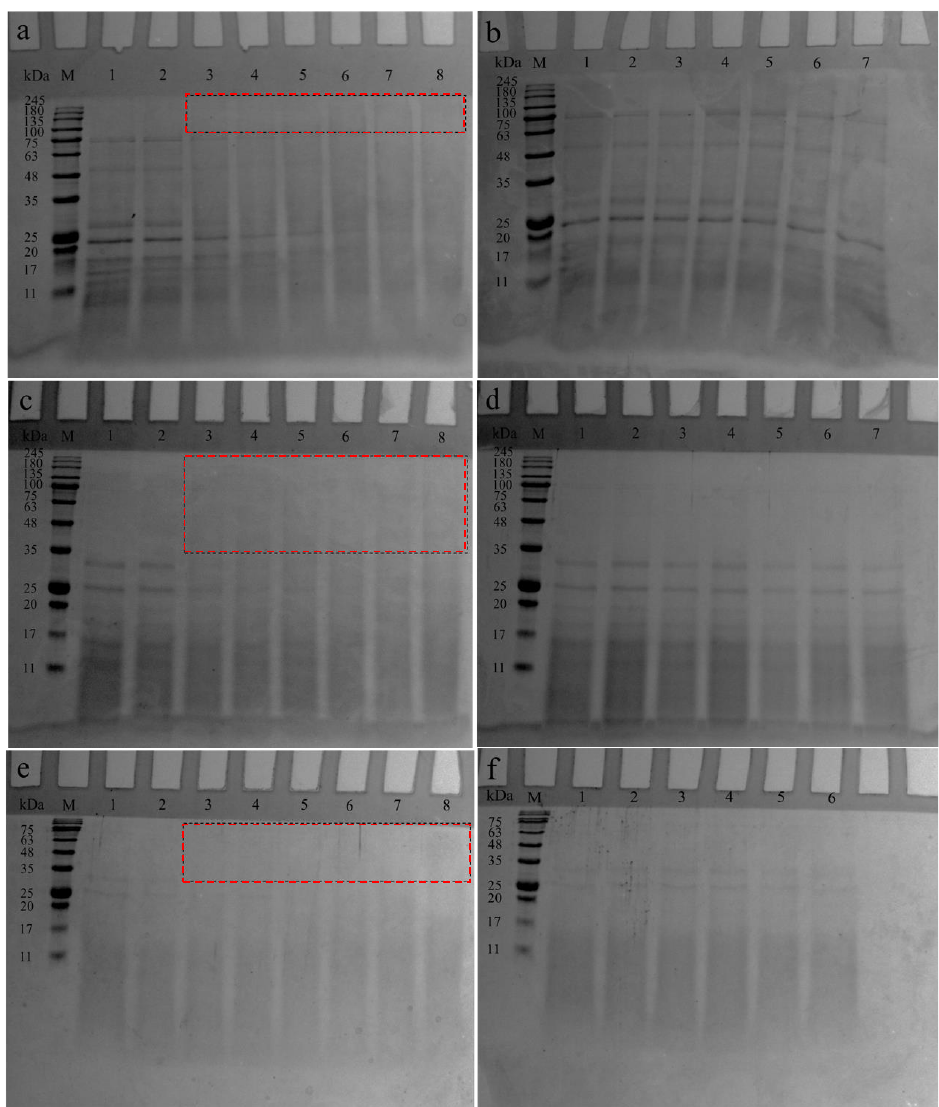
Figure 2. SDS-PAGE patterns of F30-dextran conjugate ( a ), F30 ( b ), F30-10-dextran conjugate ( c ), F30-10 ( d ), F10-dextran conjugate ( e ), and F10 ( f ) incubated at 60 °C for 0 – 24 h (M, Marker; for graph a, c, and e, lane 1 represents the F30, F30-10, or F10; lanes 2 – 8 represent the conjugates incubated for 0, 2, 4, 6, 12, 18, and 24 h; for graph ( b ) and ( d ), lanes 1 – 7 represent the F30 or F30-10 incubated for 0, 2, 4, 6, 12, 18, and 24 h; for graph ( f ), lanes 1 – 6 represent the F10 incubated for 2, 4, 6, 12, 18, and 24 h; the red-dotted box indicates the possible F30, F30-10, or F10-dextran conjugate formed during glycosylation).